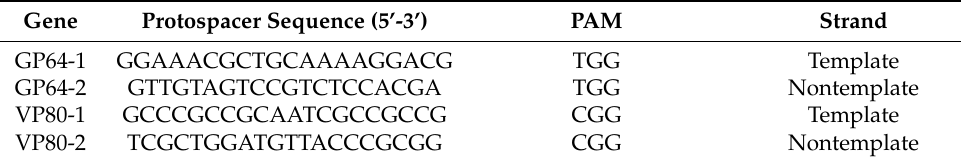
Table 2. Protospacer sequences for CRISPR